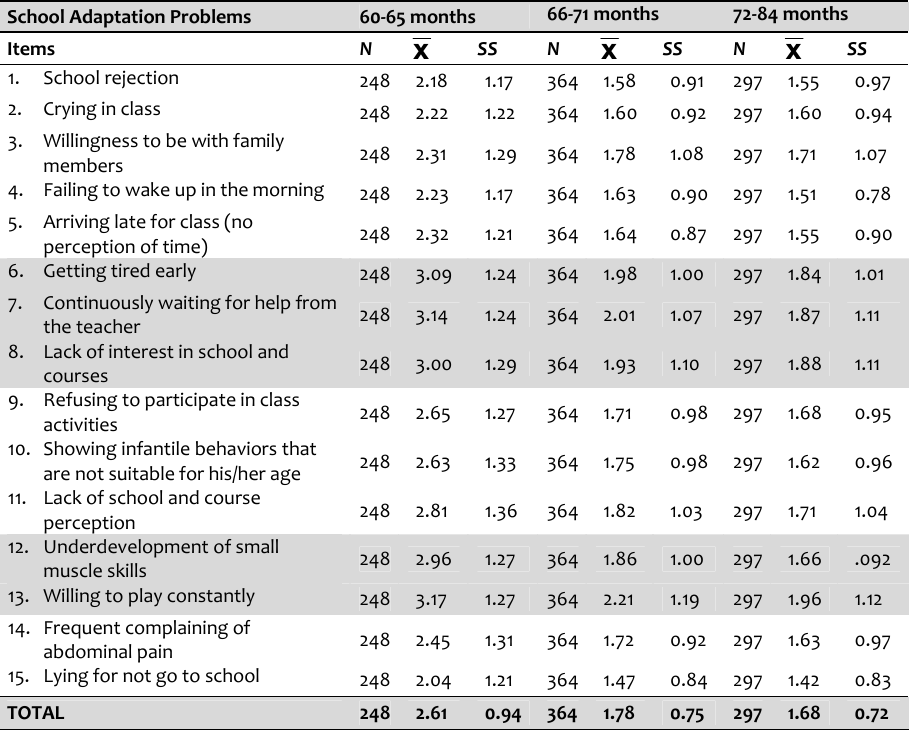
Table 2. Arithmetic Mean and Standard Deviation Values Concerning Primary School